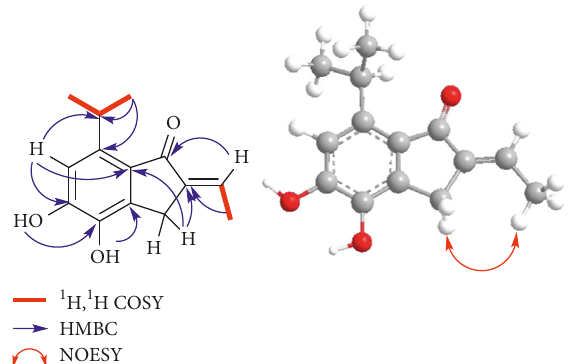
Figure 2: Key 1 H, 1 H COSY, HMBC, and NOESY correlations of 1